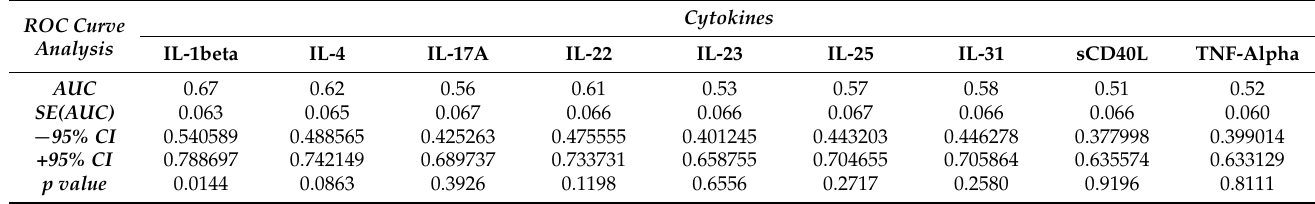
Figure 5. Univariate receiver operating characteristic (ROC) curve shows the correlation between the serum concentration of IL-1 beta ( A ) in patients with IgE-mediated allergy and other participants; ( B ) in patients with delayed-type food allergy and other participants. 4. Discussion In this study, we focused on the analysis of the serum profile of inflammatory factors in young children with food allergy (FA) and chronic symptoms of atopic dermatitis (AD). We successfully measured the concentration of nine cytokines involved in the T-helper cell type 17 immune response pathway: IL-1 beta, IL-4, IL-17A, IL-22, IL-23, IL-25, IL-31, sCD40L, and TNF-alpha. In one experiment, we examined several serum inflammatory